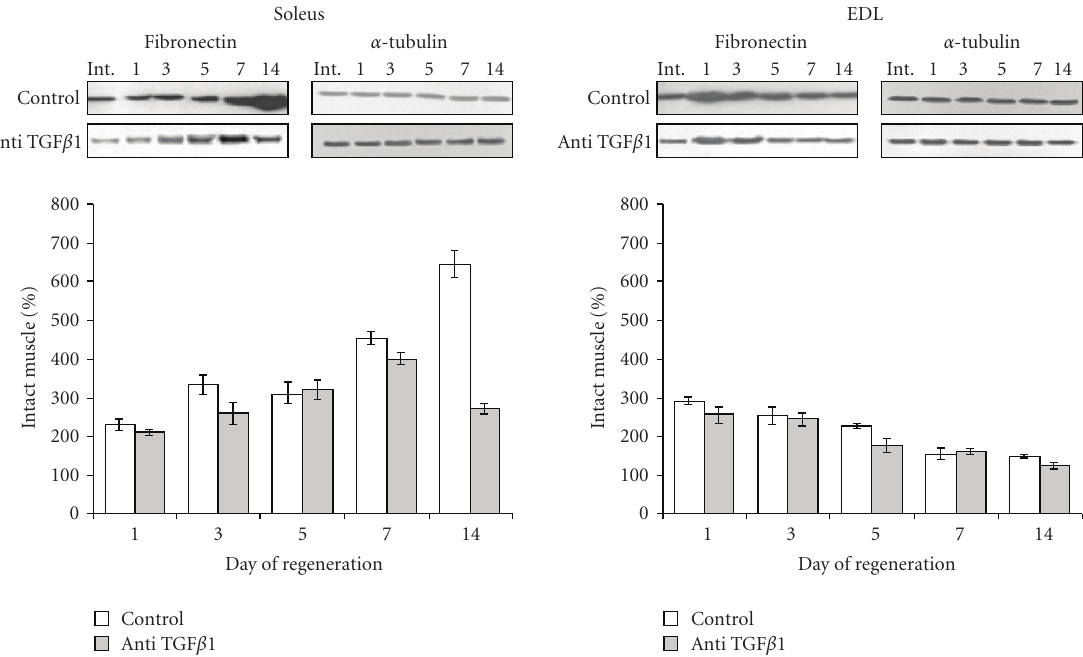
Figure 4: E ff ect of anti-TGF β 1 on fibronectin protein level during soleus and EDL muscle regeneration . Densitometric analysis of immunoblots performed on extracts from control untreated or anti-TGF β 1 treated soleus and EDL muscles at the indicated days after crush. Level found in the corresponding intact muscle was taken as reference (100%). Results are mean ± SE of 3 independent determinations each of them including 3 animals. Representative immunoblots of fibronectin from control and treated soleus and EDL muscles are also shown. α -tubulin was used as control of